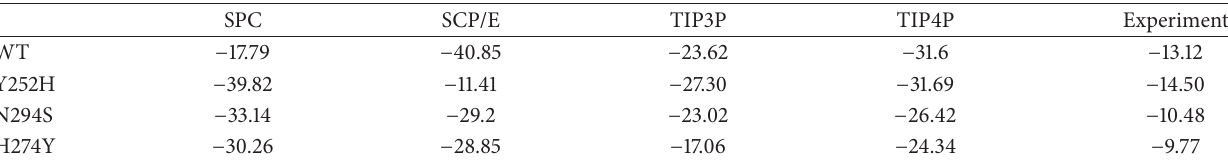
Table 7: The binding free energy Δ𝐺 (in kcal/mol) obtained by using the combination of CHARMM 27 with different water models for bind WT and mutants Y252H, N294S, and H274Y. The experimental results are taken from Collins et al. [23]. SPC SCP/E TIP3P